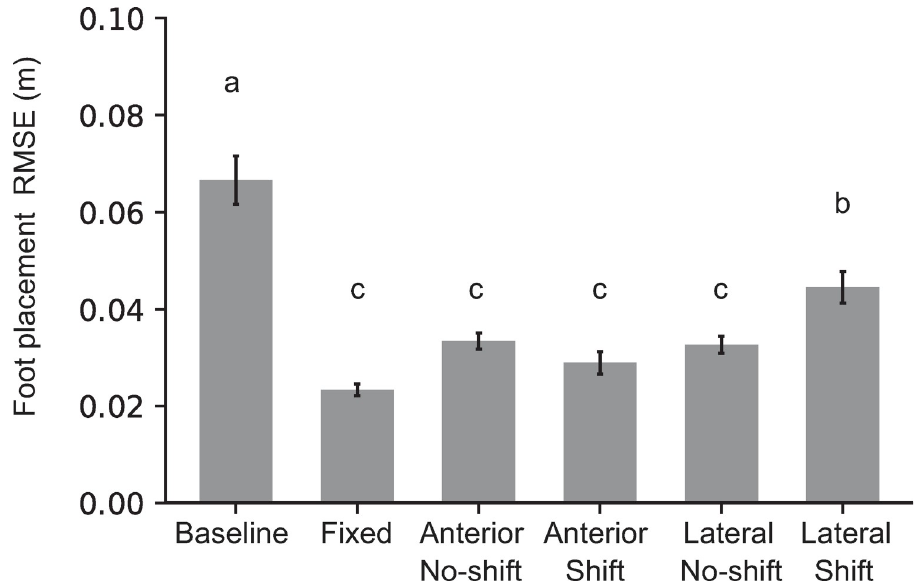
Fig 2. Mean and standard error for foot placement RMSE for each task. RMSE is computed separately for the no- shift and shift trials for the Anterior-shift and Lateral-shift tasks. Means with different letters are significantly different from one another.